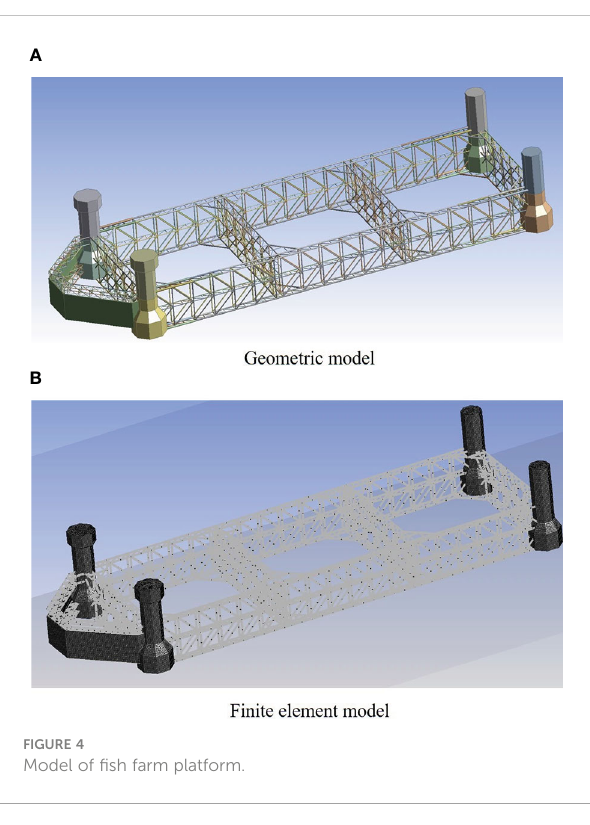
FIGURE 4 Model of fi sh farm platform.